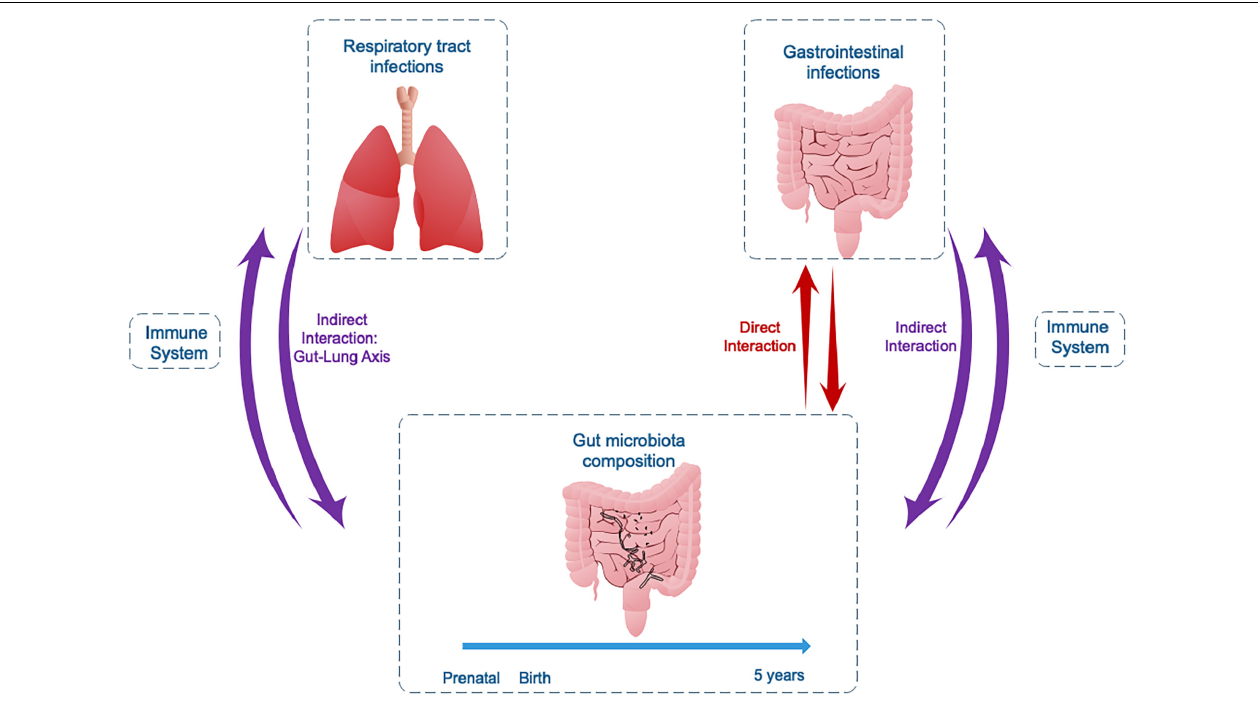
FIGURE 2 | Bidirectional interactions between the gut microbiota and gastrointestinal or respiratory tract infections in